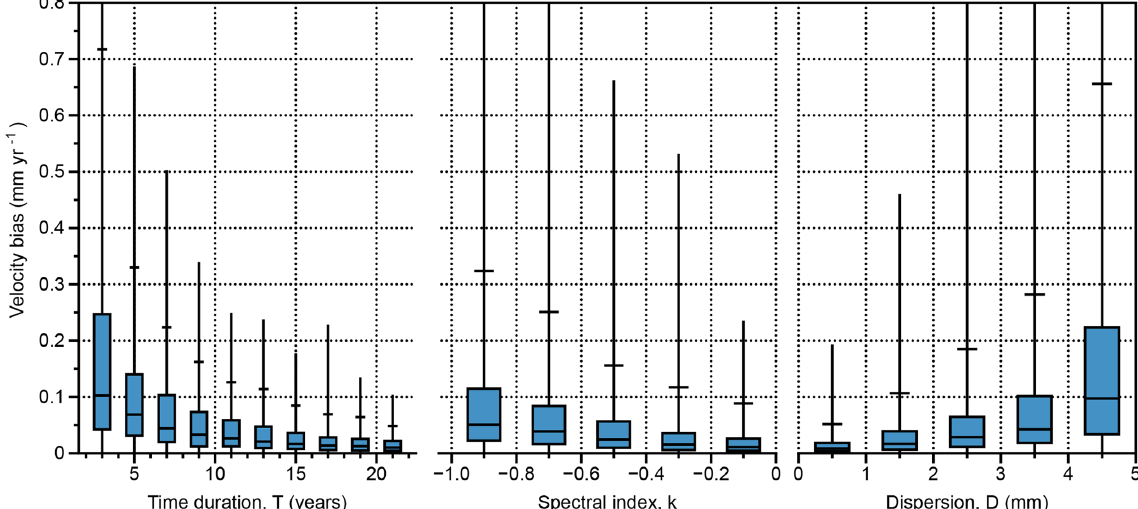
Figure 4. Whisker plots of velocity bias as a function of the duration ( T ), spectral index ( k ), and dispersion ( D ) for series including only colored noise. Whiskers diagrams show the data quartiles (25%, 50%, 75%) in blue, the extremes (0%, 100%) with the vertical black line, and the 95 percentile ( v 95 ) with the horizontal black line.